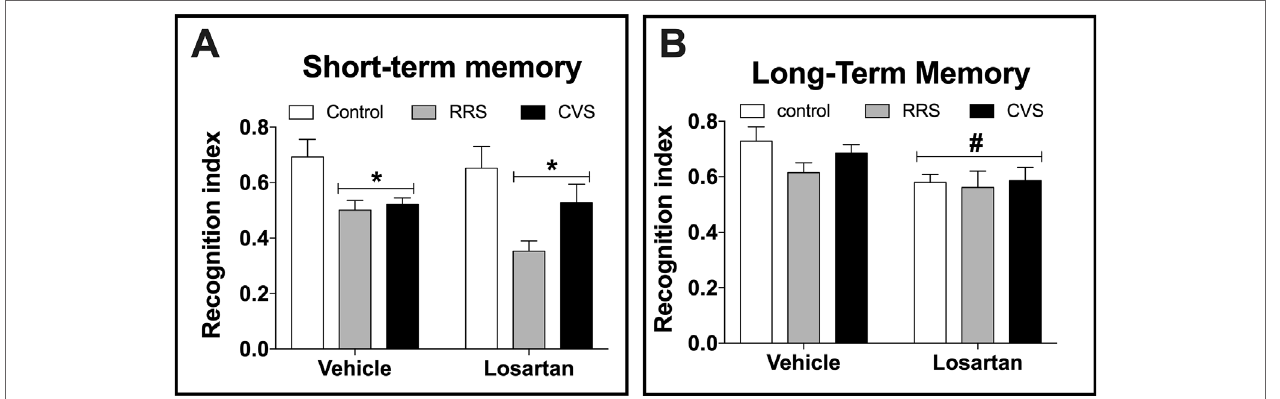
FIGURE 3 | Cognitive non-emotional performance in the novel object recognition (NOR) test in animals treated with either vehicle or losartan control (white bars) and subjected to RRS (gray bars) or CVS (black bars). (A) Object discrimination rate at day 1 of NOR test (short-term memory). *P < 0.05 versus respective control group, two-way ANOVA (n = 9/group). (B) Object discrimination rate at day 2 of NOR test (long-term memory). # P < 0.05 versus vehicle groups, two-way ANOVA (n = 9/group). The bars in all graphs represent the mean ±